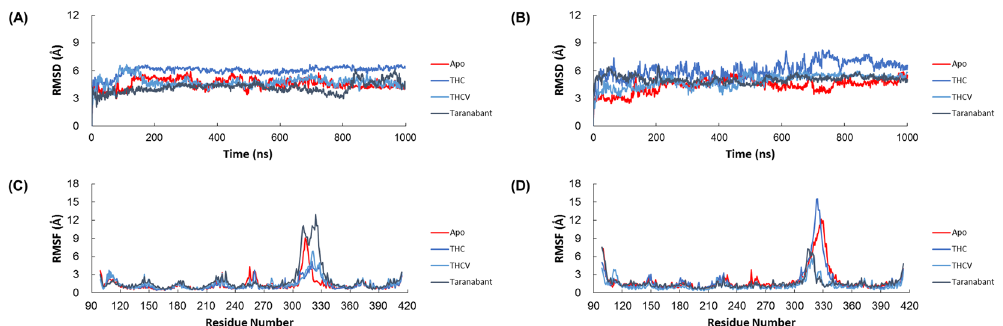
Figure 4. The RMSD and RMSF values obtained from MD simulations. The RSMD of the backbone atoms of ( A ) inactive and ( B ) active conformations of CB1 structures were calculated against their initial structures. The RMSF of the residues of ( C ) inactive and ( D ) active conformations of CB1 structures were also calculated against their initial